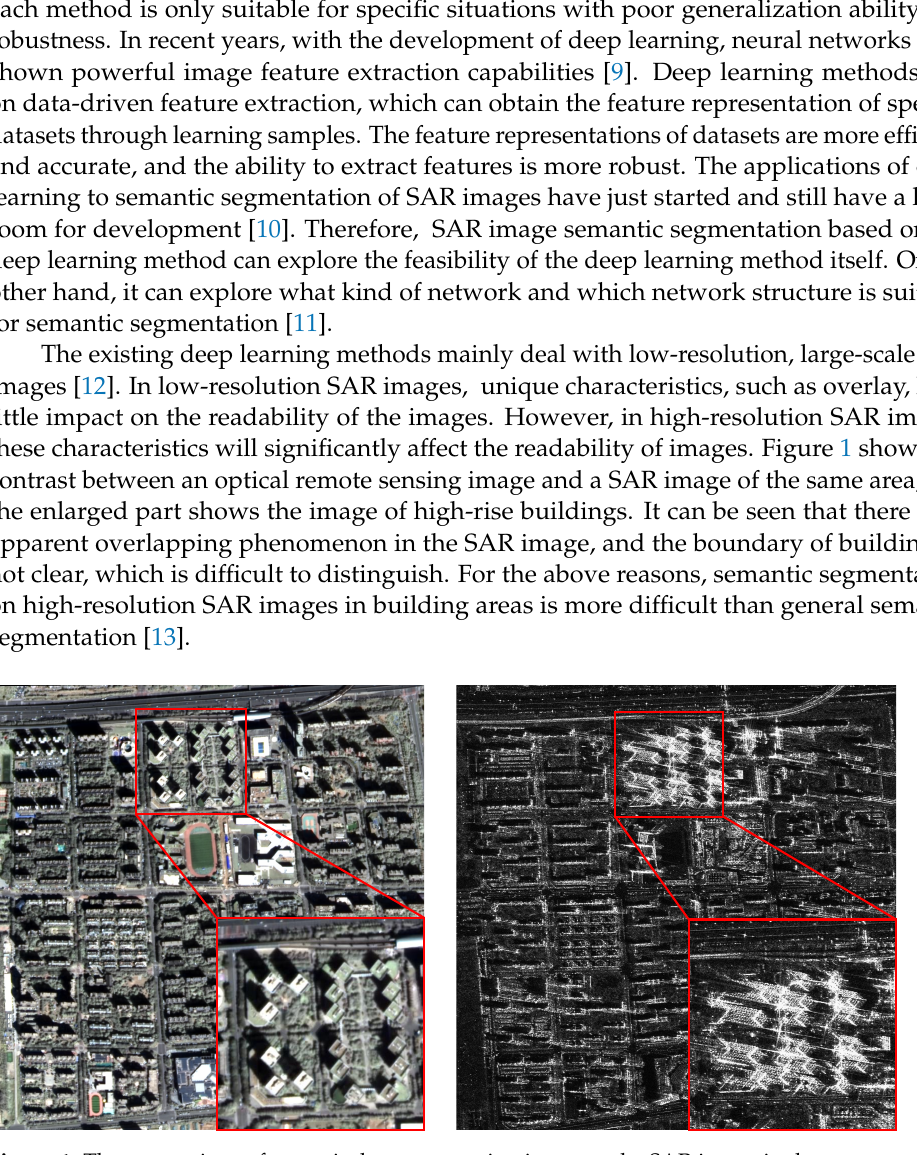
Figure 1. The comparison of an optical remote sensing image and a SAR image in the same area. The left image is the optical remote sensing image, the right image is the SAR image, and the high-rise building area is